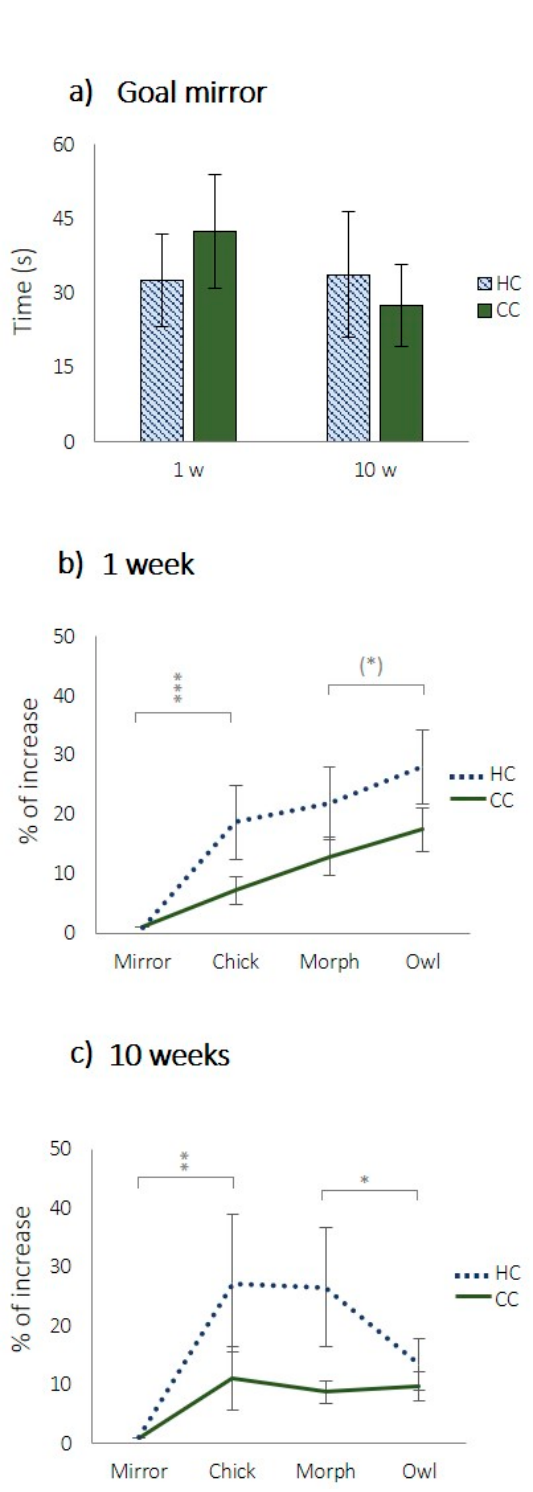
Figure 4. Latency to reach goal line in the straight alley maze in ( a ) seconds when exposed to mirror, and ( b , c ) in % increase compared to mirror at ( b ) 1, and ( c ) 10 weeks of age, where HC = hatchery stressed chicks, and CC = control chicks, (*) p < 0.1, * p < 0.05, ** p < 0.01, *** p < 0.001.